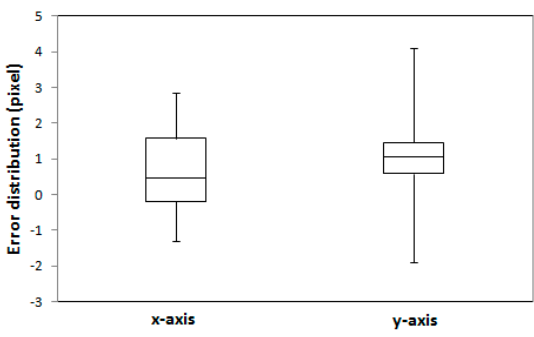
Figure 16. Error distribution of the 16 check points for the Vaihingen dataset.